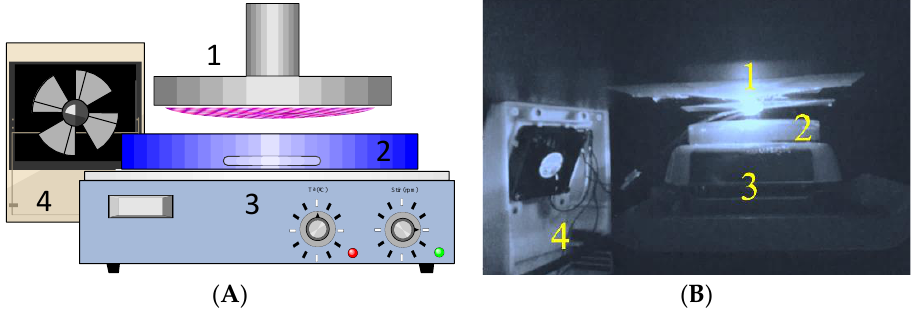
Figure 7. Reactor set-up, schema ( A ), and real ( B ): UV LED (1), crystal open-wide-reactor (2), magnetic stirrer (3), and refrigerator fan (4).